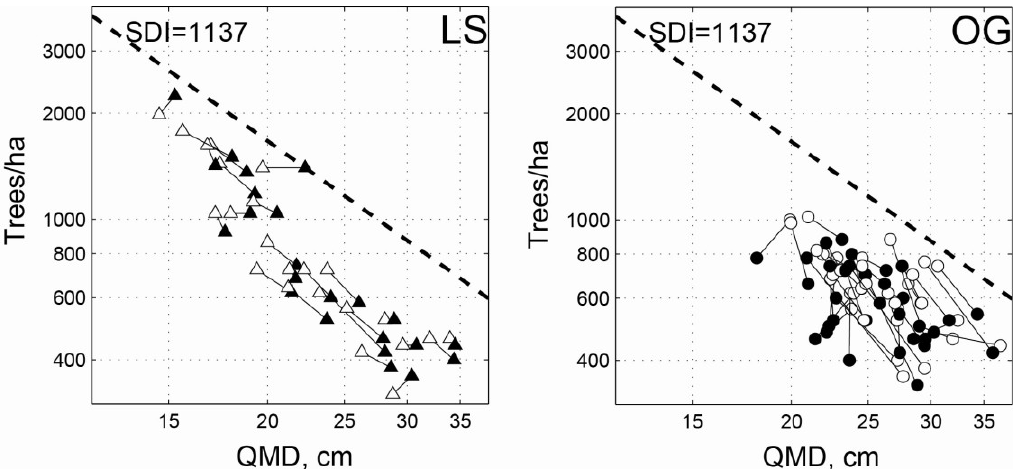
Figure 1. Trajectories of the late-successional (LS) and old-growth (OG) stands in Reineke space, with open symbols indicating position at the initial measurement, and solid symbols indicating position in 2011. A dashed line at constant stand density index of 1137, the maximum observed on any LS or OG plot, is shown for